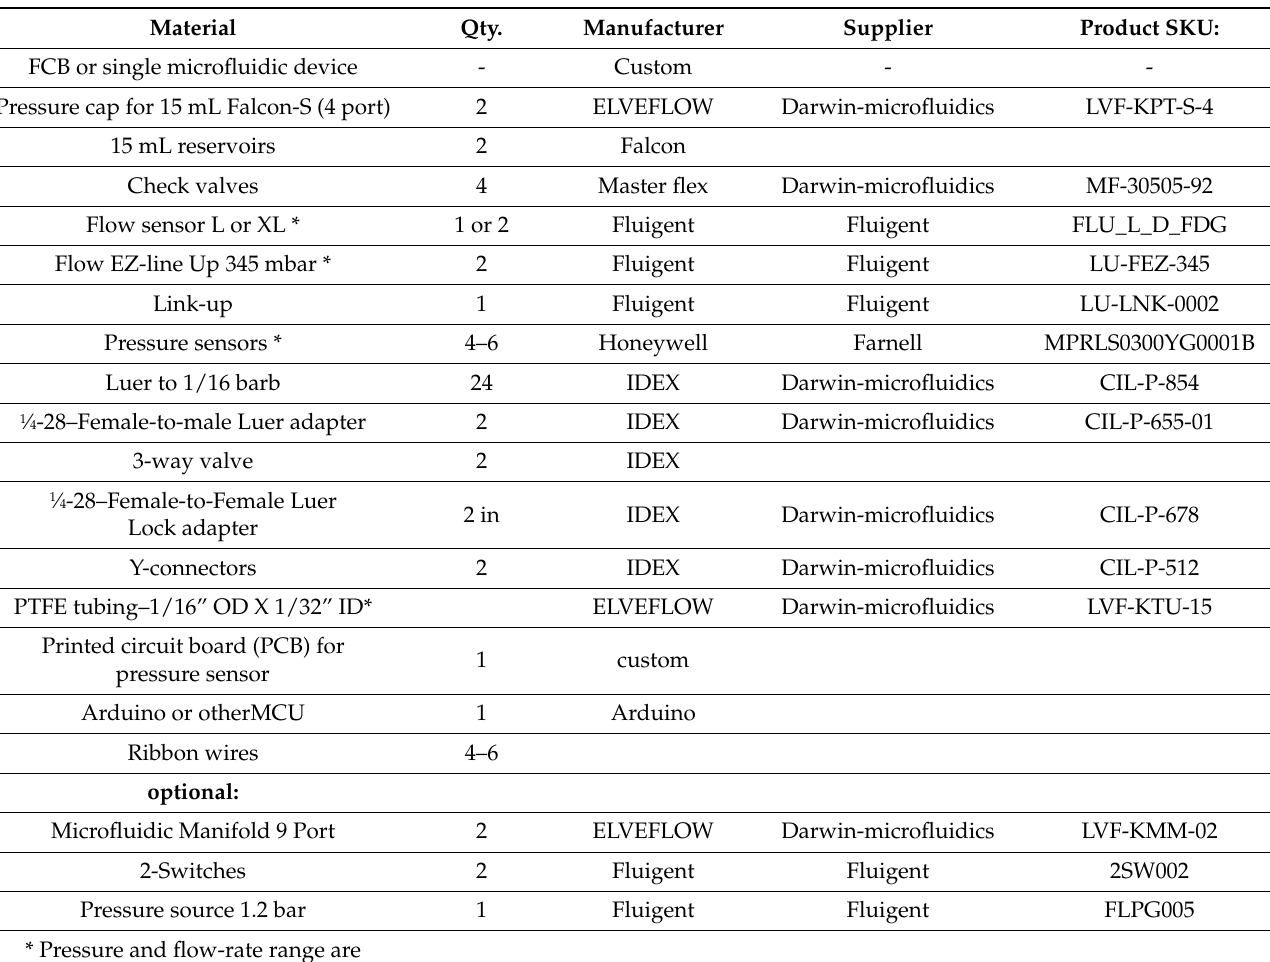
Table 1. Materials used for assembly of various fluidic